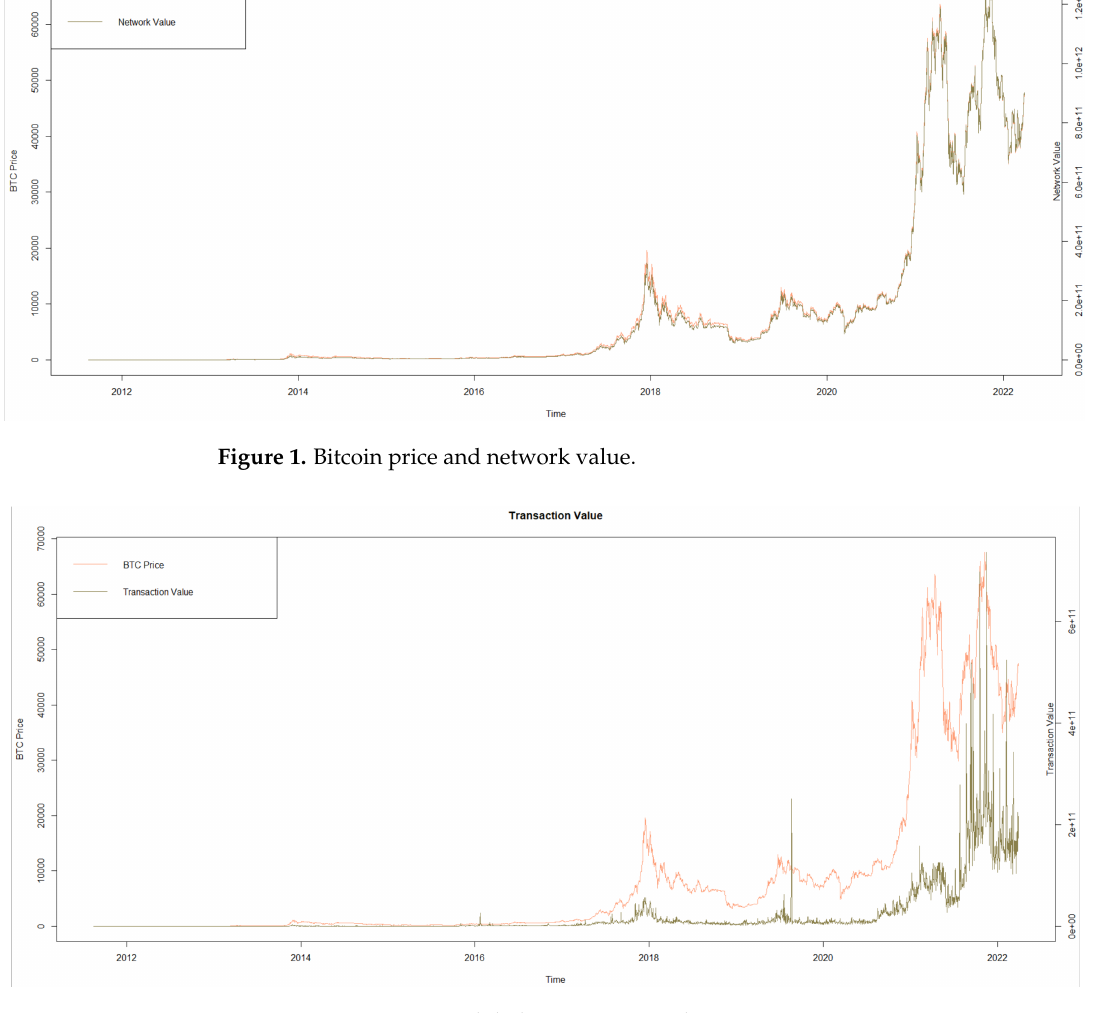
Figure 2. Bitcoin price and daily transaction value.